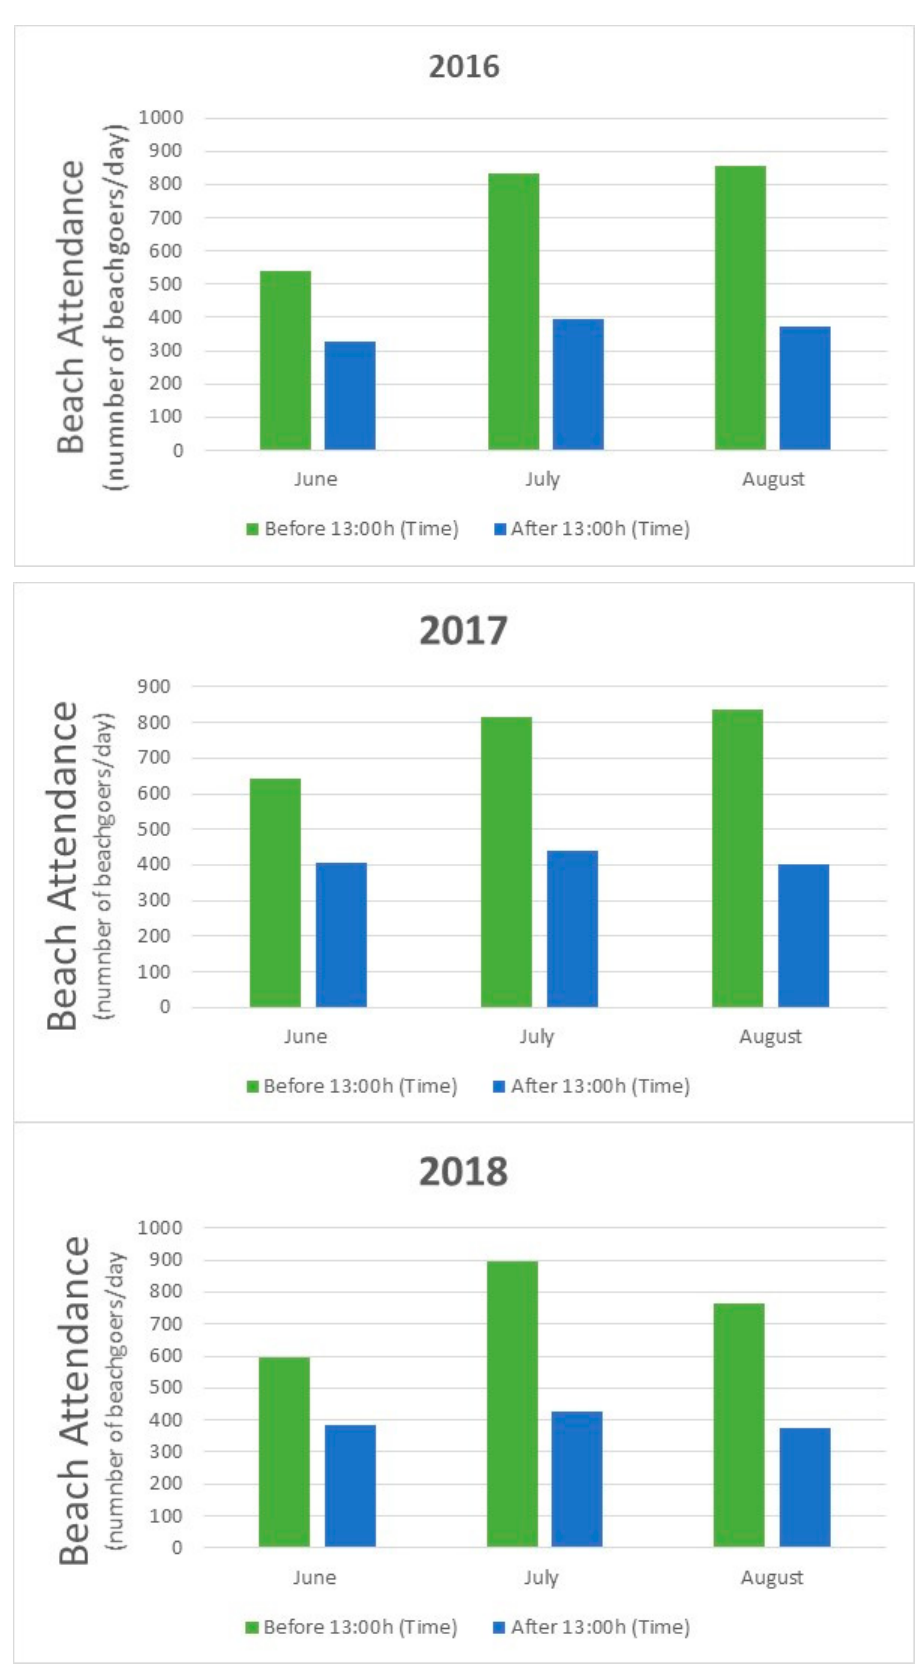
Figure 6. Morning and afternoon total average beach attendance per day.